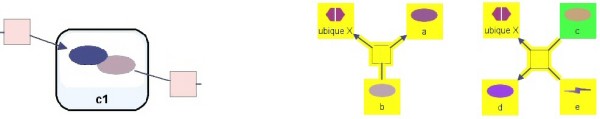
Example traversals of complexes and ubiquitous molecules. (left) The traversal reaching complex "c1" from the left transition will continue to the right transition only if the "Link Members of Complex" option is true. (right) Whether or not protein states "a" and "b" are in the 4-neighborhood (yellow) of state "c" (green) depends on whether traversal over ubiquitous molecules ("ubique X") is allowed. In this case, it was allowed.